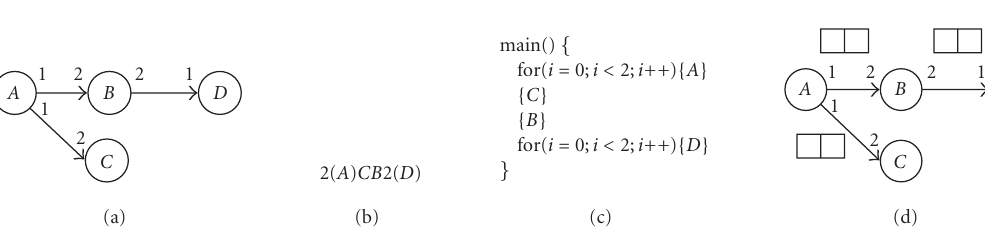
Figure 1: (a) SDF graph example, (b) a scheduling result, (c) a code template, and (d) a bu ff er allocation.